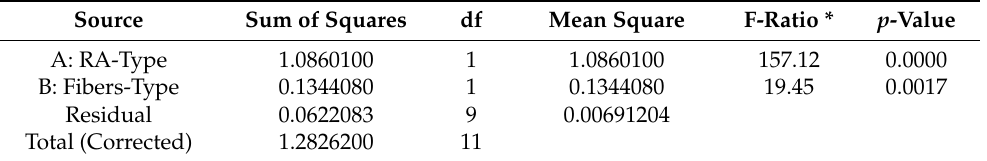
Table 9. Analysis of the Variance for the values of Flexural Resistance (MPa).